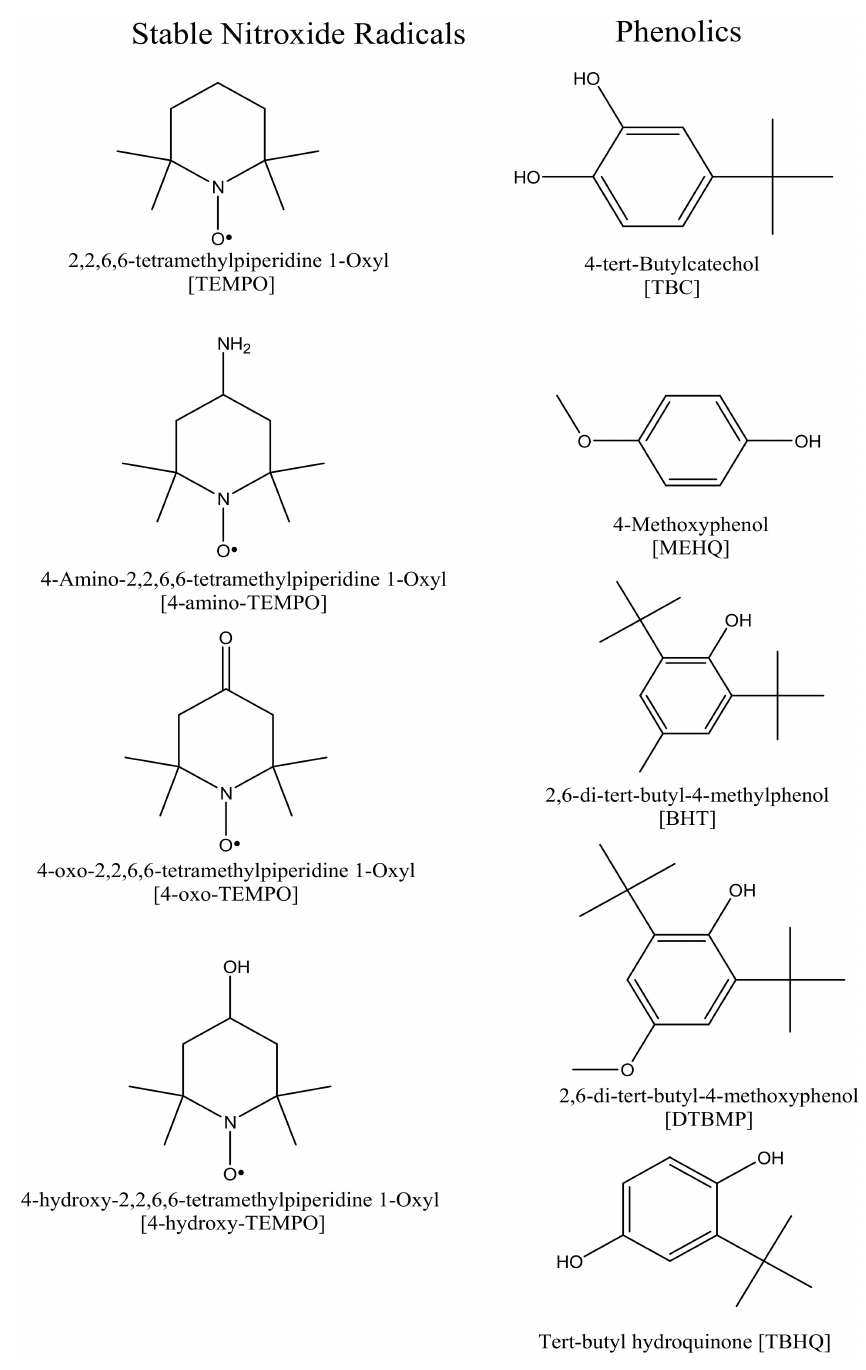
Figure 4. The name and structure of stable nitroxide radicals (SNR) and phenolic components. Hydrogen atoms are omitted for